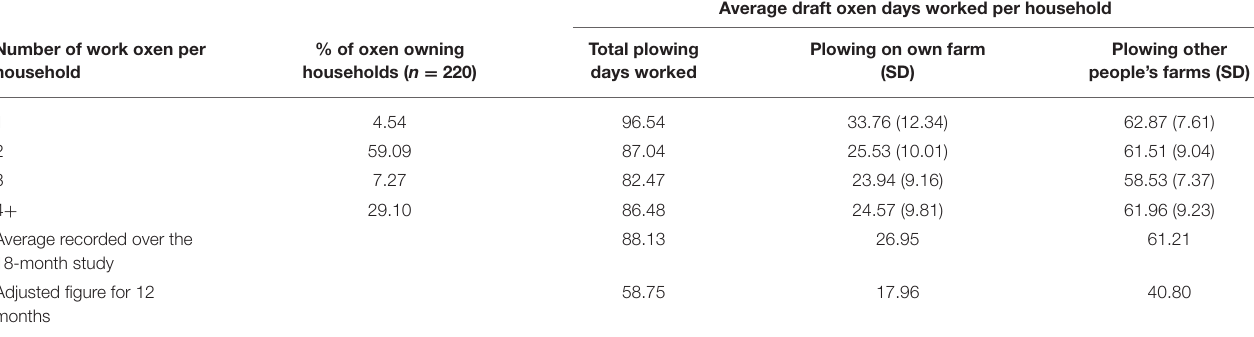
TABLE 2 | Draft oxen ownership and work patterns among the RAP households during the